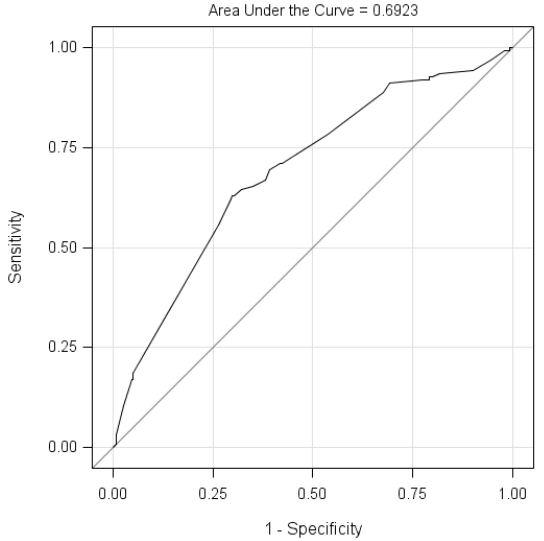
Figure 1. The Receiver Operating Characteristic Curve (ROC) for the logistic regression model. The ROC curve is a plot of sensitivity (events predicted to be events) versus 1-specificity (nonevents predicted to be events). The area under the ROC curve (AUC) could be used as a measure of goodness of fit.